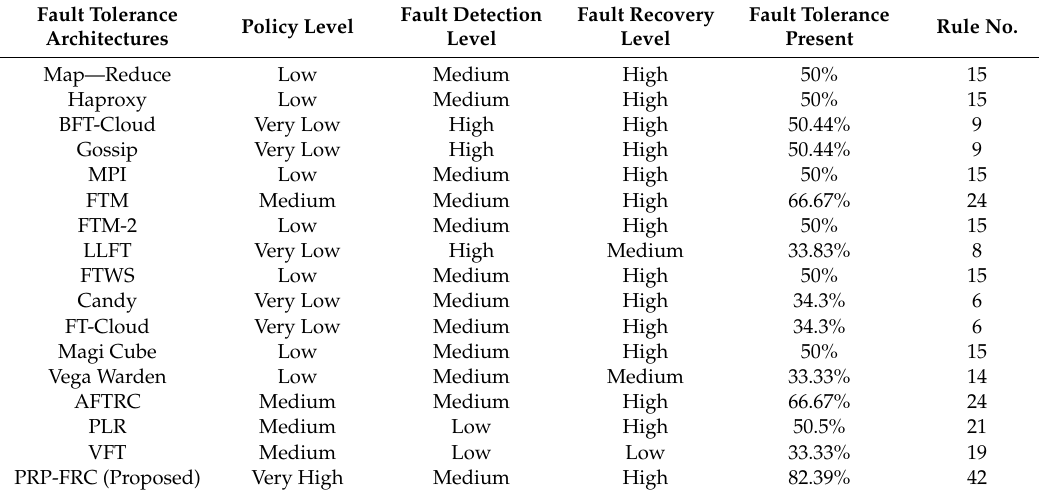
Table 11. Comparing FT capability of our proposed architecture with other existing architectures in the FIS (3) engine.